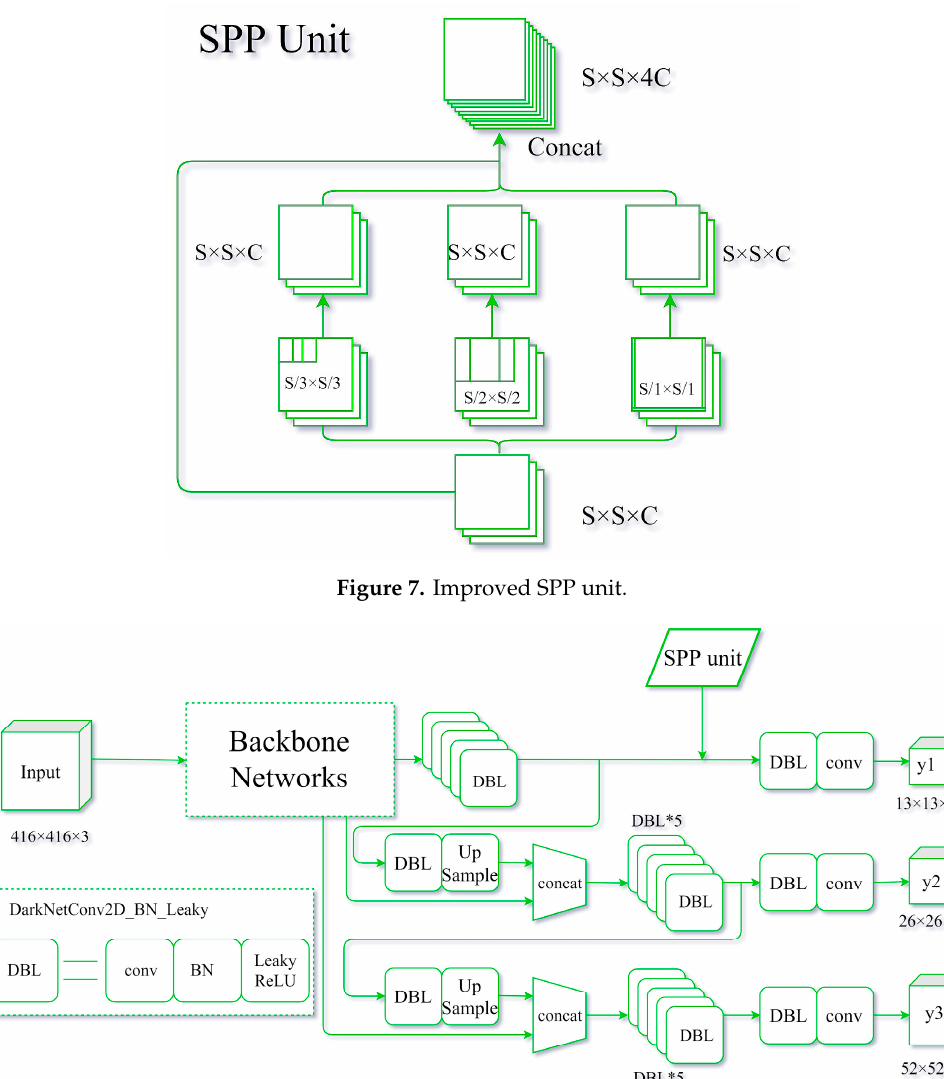
Figure 8. Structure of the SPP-YOLOv3 model.